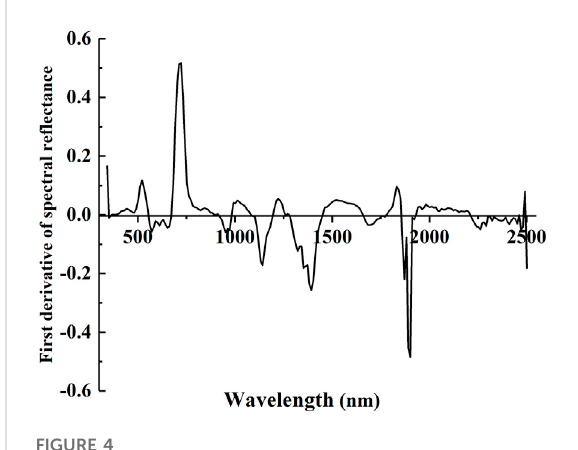
FIGURE 4 Spectral data after fi rst-order differential processing strengthened the change of the absorption valley or re fl ection peak at each